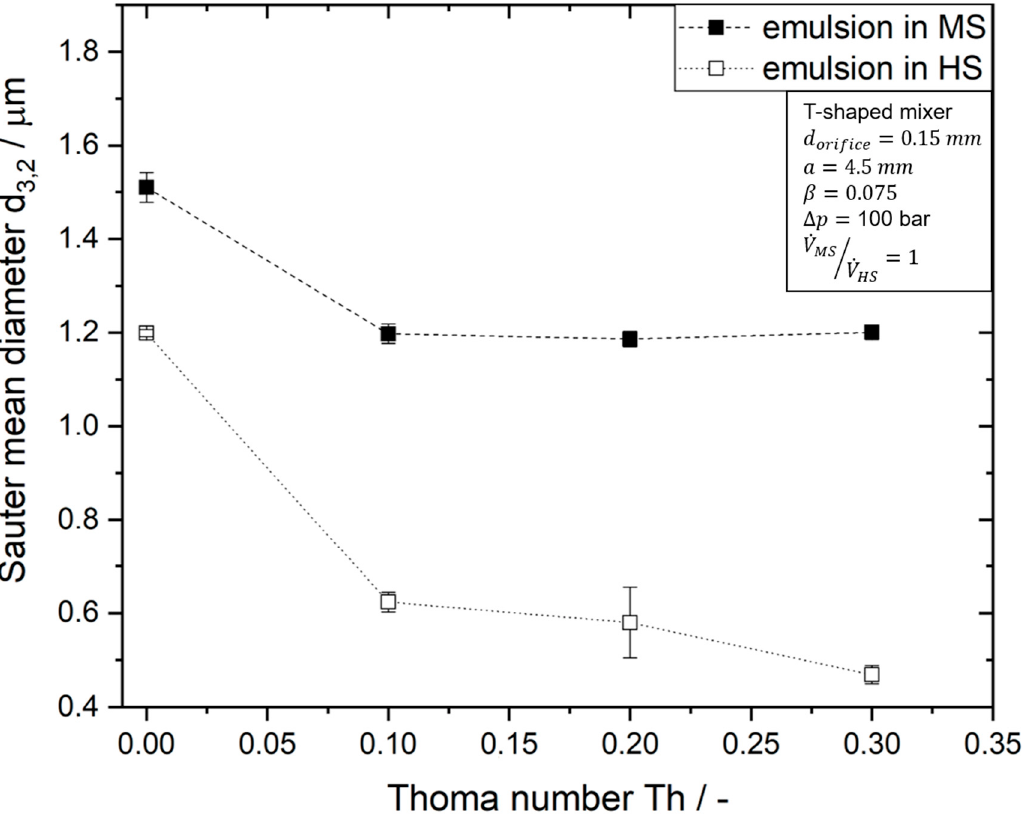
Figure 7. Influence of Thoma number Th on d 3,2 for ∆ p = 100 bar.